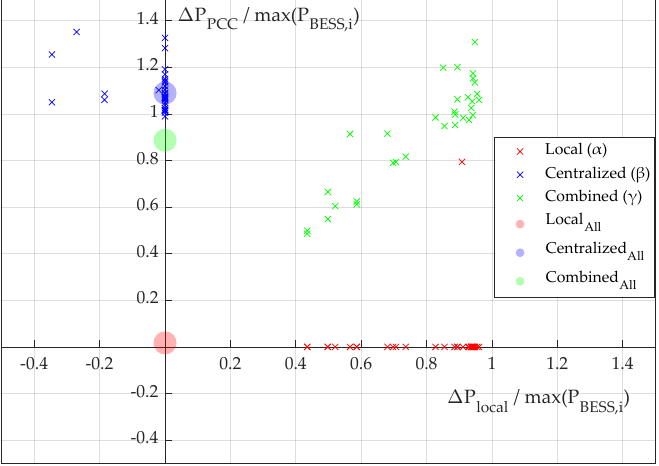
Figure 6. Relative peak load reduction for each simulation with various operating strategies for the battery energy storage system (BESS). The reduction of the peak load at the local node b (= location of the BESS) is plotted on the abscissa and the reduction of the peak load at the point of common coupling (PCC) can be seen on the ordinate. The red crosses show the reduction if the BESS is operated with strategy α . The blue crosses show the results for strategy β and the green ones for the combined approach (Strategy γ ). The filled circles show the reduction of the peak load at the PCC if all 32BESSs are integrated into the grid